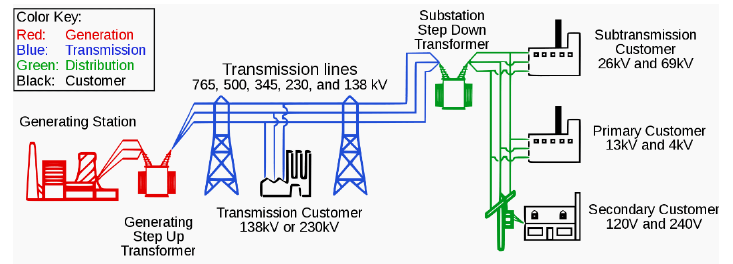
Fig. 1 The hierarchical topology of the electric power communication network.